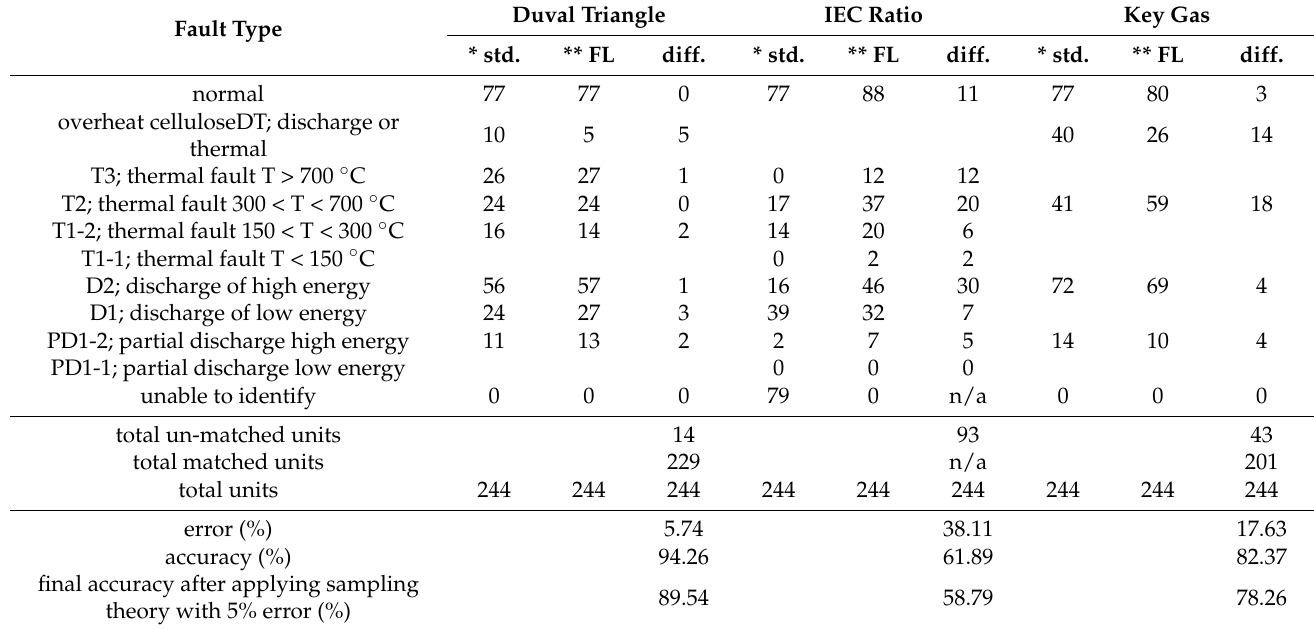
Table 16. Comparison of results from fuzzy logic approach to three DGA standard diagnosis methods. Fault